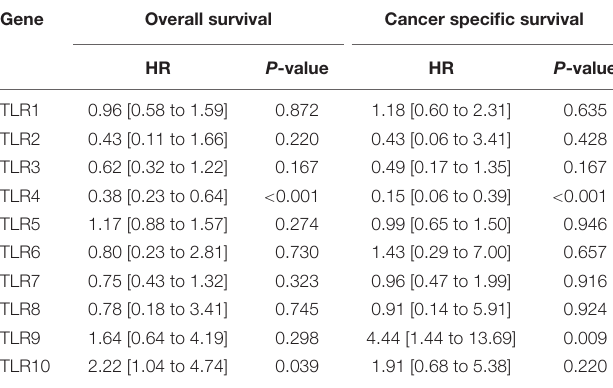
( Table 2 ). The Kaplan-Meier curves also verify the prognostic value of TLR4 ( Figures 1C,D ).